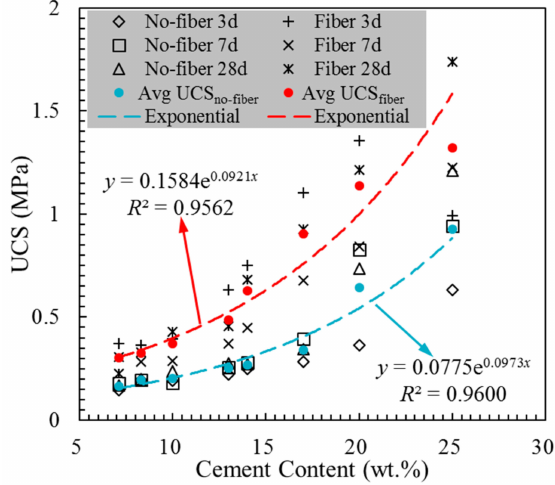
Figure 6. The e ff ect of the cement content on the